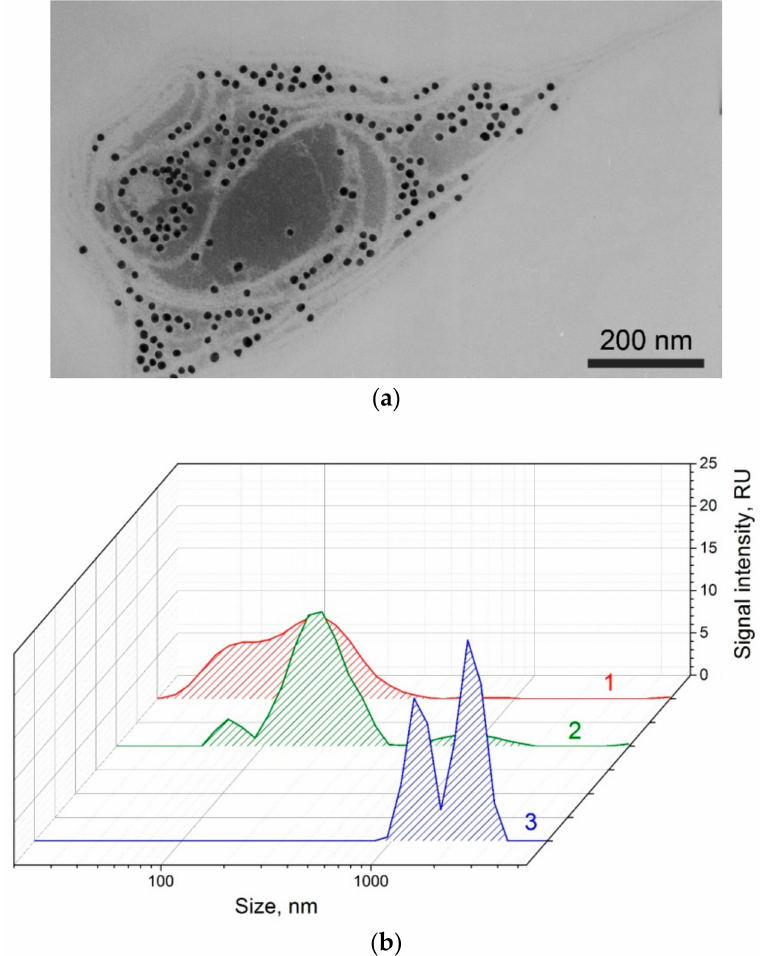
Figure 9. Immune complexes between PVY and GNP conjugates with antibodies. ( a ) Microphotograph by TEM. ( b ) Distribution of the hydrodynamic radii for GNP conjugates with antibodies (1), PVY (2), and PVY–conjugate complexes (3) by dynamic light scattering